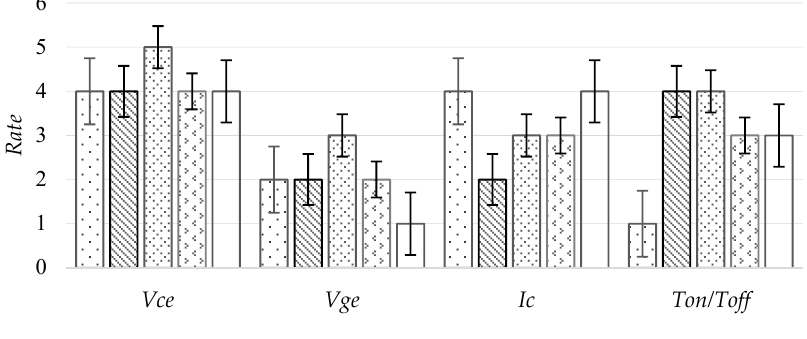
Figure 4. Performance comparisons of the measured data from insulated gate bipolar transistor (IGBT).